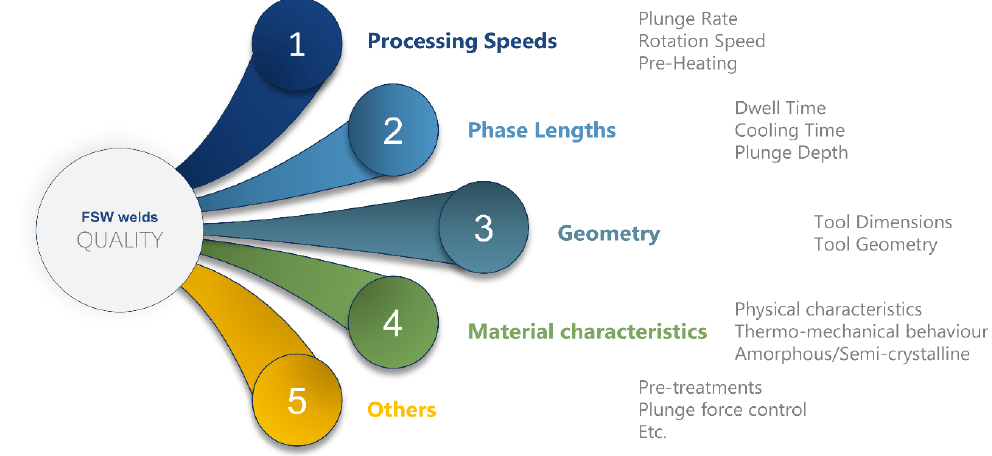
Figure 30. Factors influencing the quality of the welds. Materials 2020 , 13 , x FOR PEER REVIEW Table 5. Classification of process parameters for FSSW.